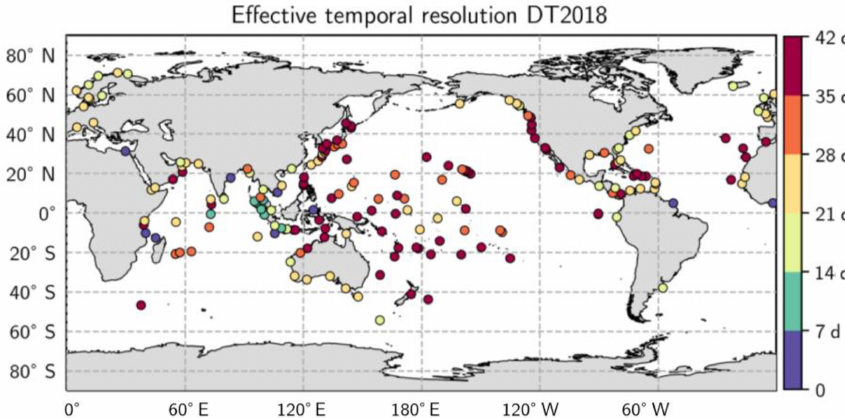
Figure 3. Effective temporal resolution in days of the DUACS-DT2018 maps. Unit in